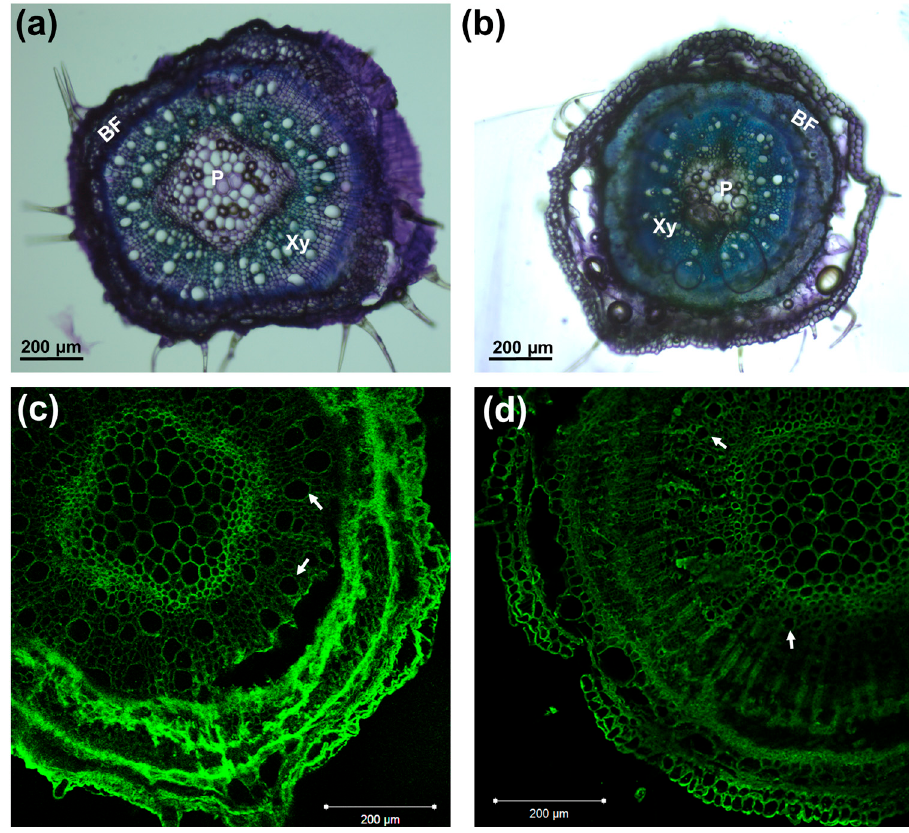
Figure 1. Toluidine blue staining of cross sections of control ( a ) and salt-exposed ( b ) hypocotyls; CBM3a immunodetection in control ( c ) and salt-exposed plants ( d ). Arrows indicate xylem vessels. BF: bast fibers; Xy: xylem; P: pith.